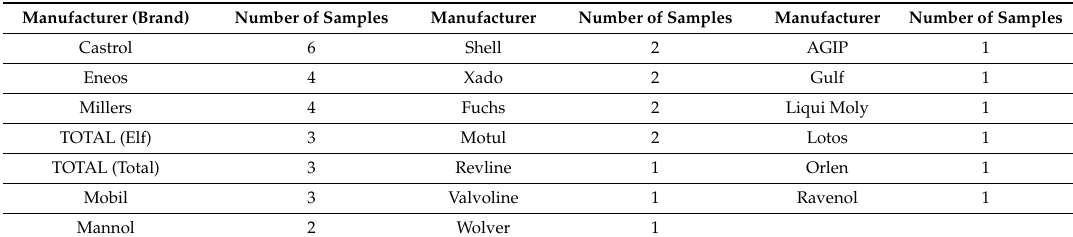
Table 1. Number of oil samples collected from tested